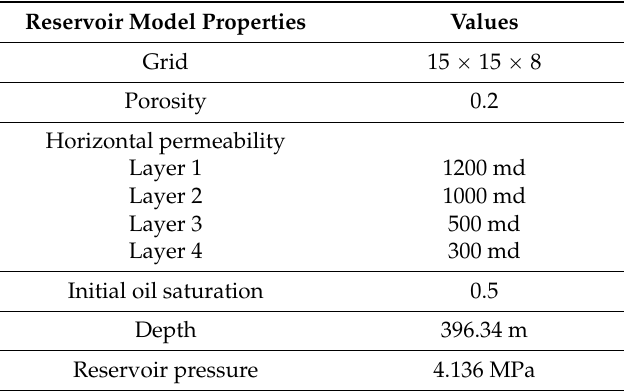
Table 1. Reservoir